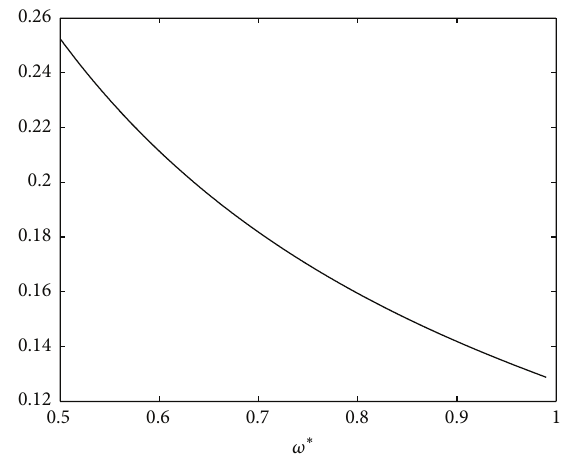
Figure 9: Plot of the l.h.s. of (65) with respect to the possible equilibrium fractions 𝜔 ∗ ∈ [ 1 / 2 , 1 − 1 /𝑁)